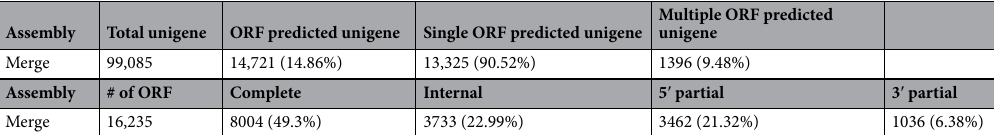
Table 2. Statistics of Open Reading Frame (ORF)